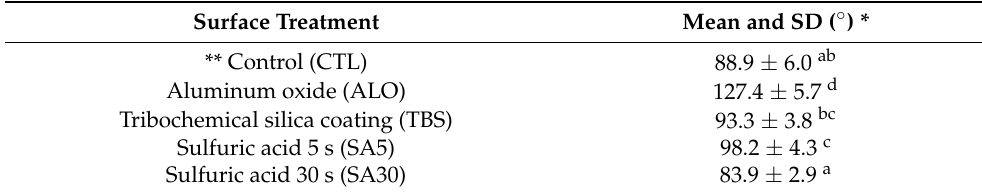
Table 4. Contact angle measurements. Mean and standard deviation of the contact angle measure- ment of specimens with different surface